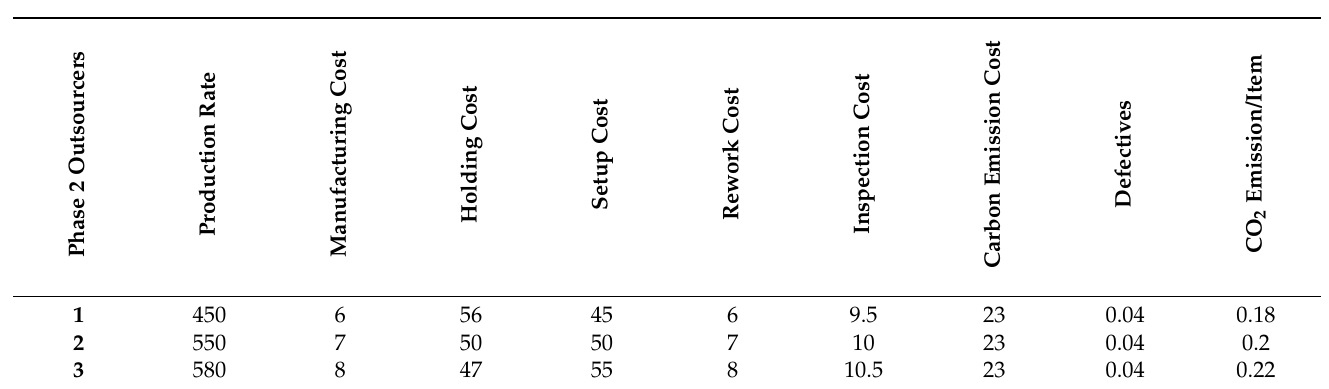
Table 3. Outsourcing data (spare-part-manufacturing industry).